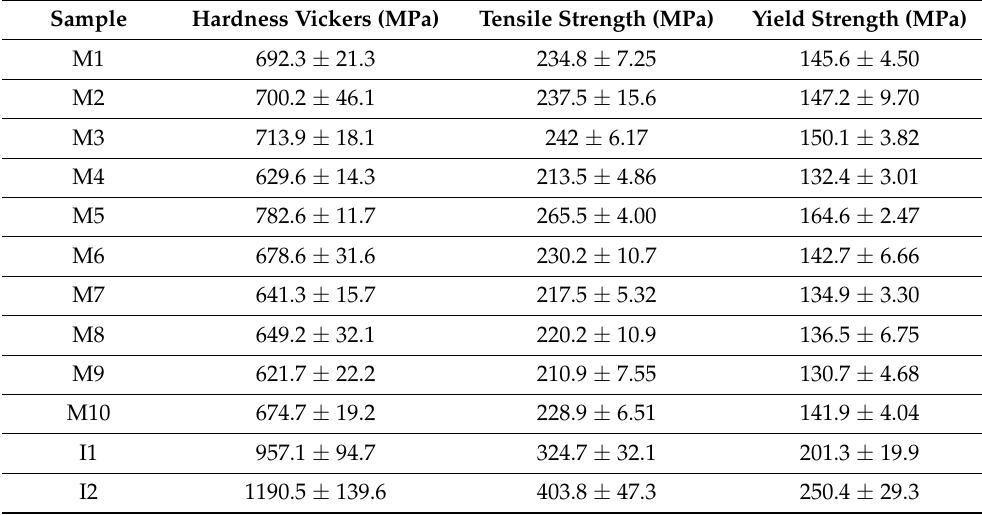
Table 2. Micro-hardness, tensile and yield strength values of SPS Al-based nanocomposites.